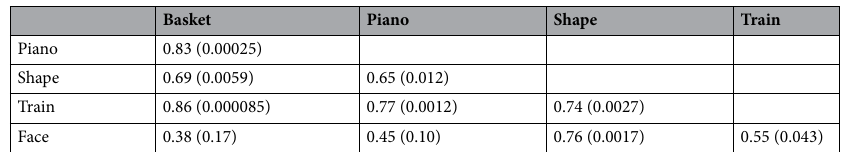
Basket Piano Shape